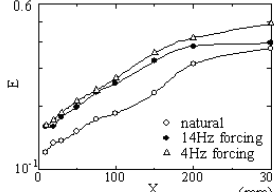
Fig. 18 Amplitude distribution of 1/4 subharmonics (with 4Hz forcing);(a)X=10-75mm,(b)X=100-20mm.